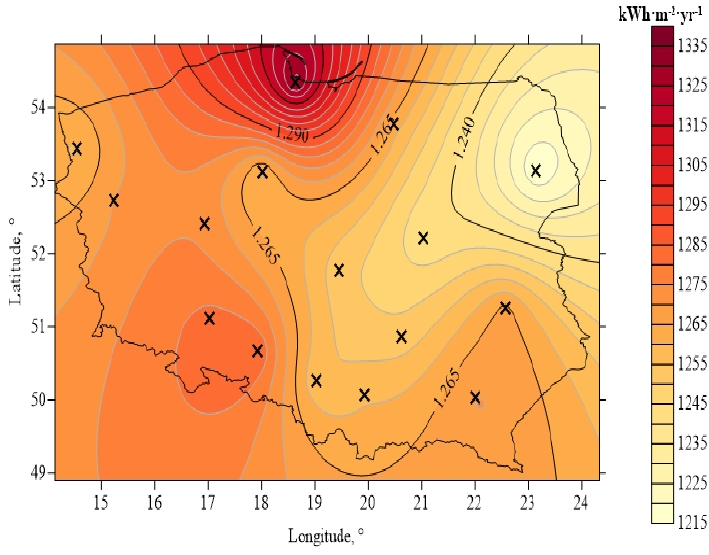
Figure 4. Map of solar radiation intensity in Poland.